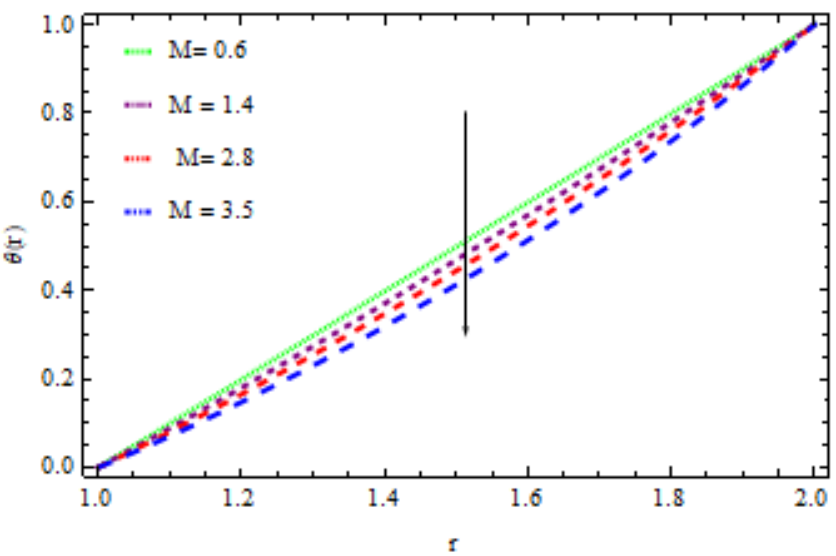
Figure 12. The influence of M on temperature distribution for Reynolds’ model (RM) when